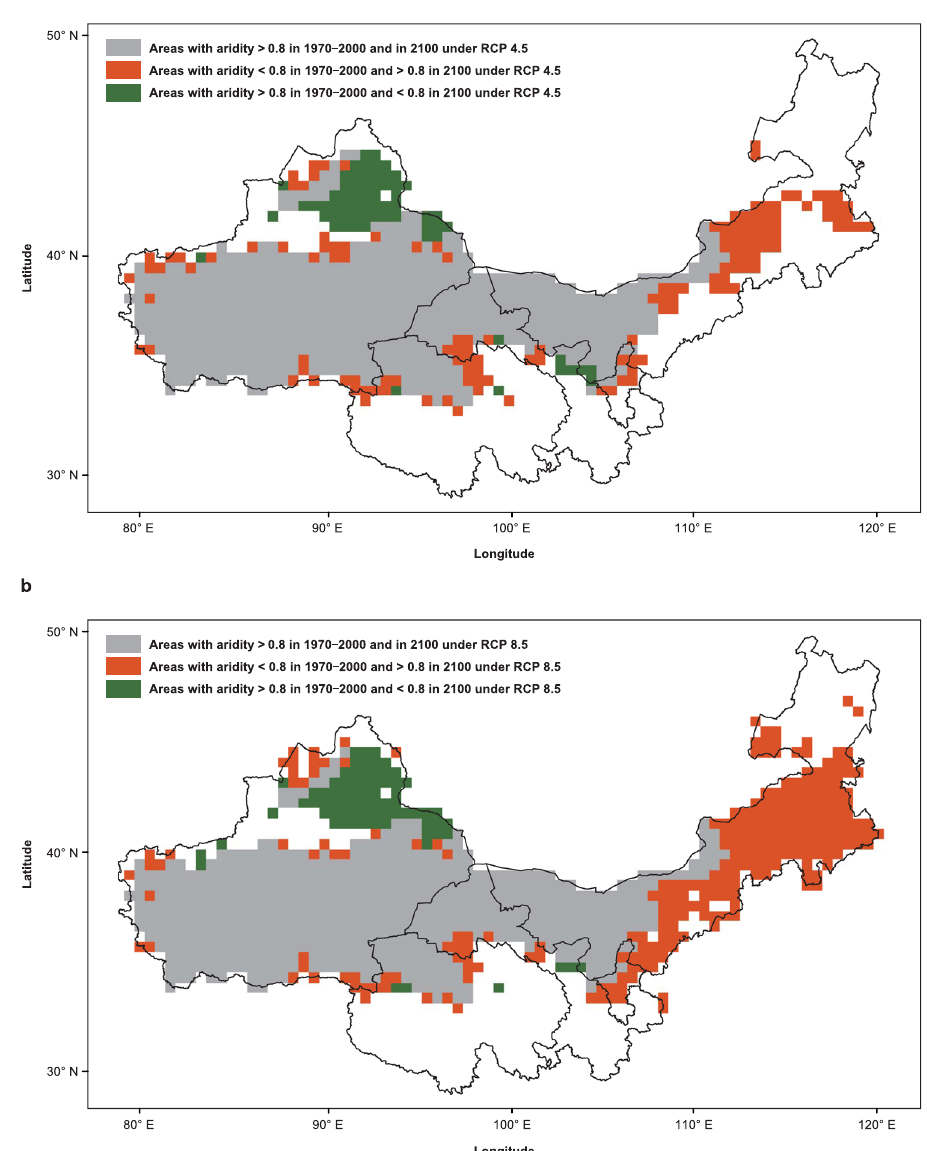
Fig. 6 Predicted future changes in areas crossing 0.8 aridity level in drylands across northern China. a , b Predictions of future changes in areas that will cross 0.8 aridity level are shown for between 1970 – 2000 and 2100 by the IPCC ’ s RCP 4.5 (i.e., assuming saturated increase in CO 2 emissions; ( a ) and 8.5 (i.e., assuming sustained increase in CO 2 emissions; ( b ) scenarios in drylands across northern China, respectively. The blank areas are outside of the range considered for this study (i.e., areas that are dry-subhumid regions, semiarid regions, and non-drylands